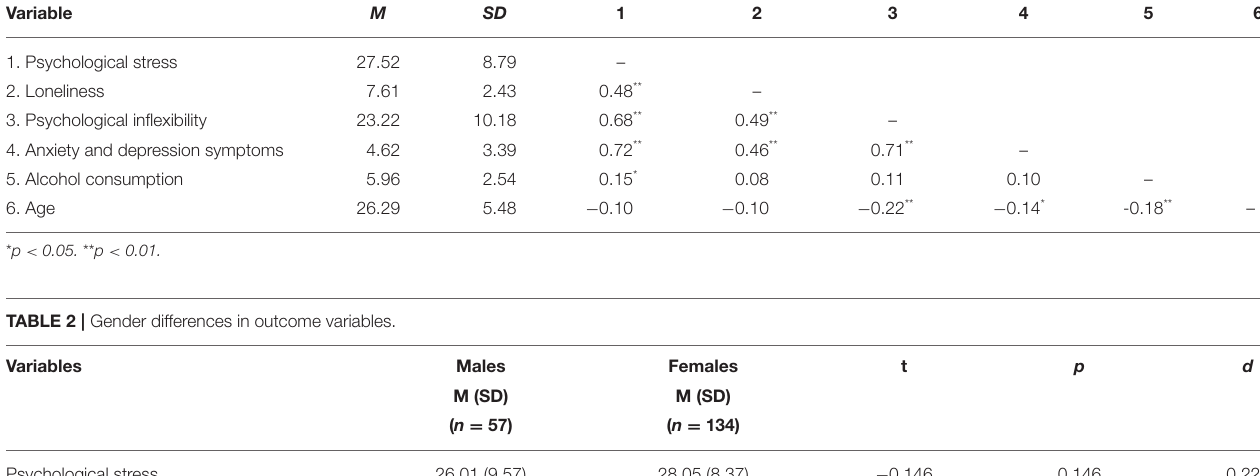
TABLE 1 | Descriptive statistics and correlations for main study variables. Variable